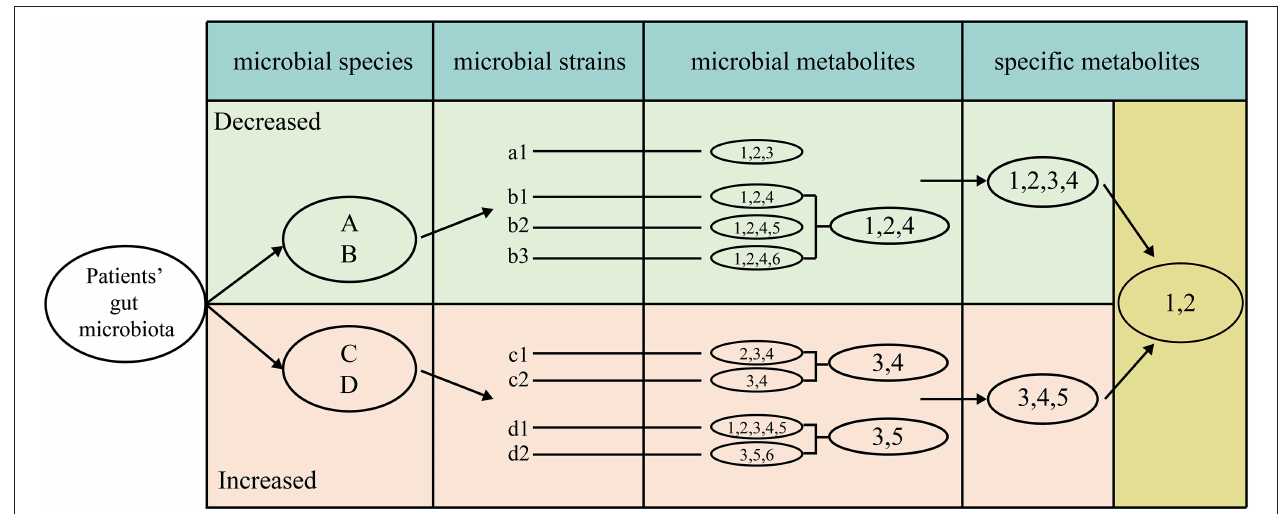
FIGURE 1 | The detailed process of screening metabolites specific for one disease, which as four steps, extracting metabolites for each strain, intersecting the metabolites among different strains in each species, uniting the metabolites for all beneficial and all detrimental microbes, subtracting the union of beneficial metabolites to detrimental metabolites.